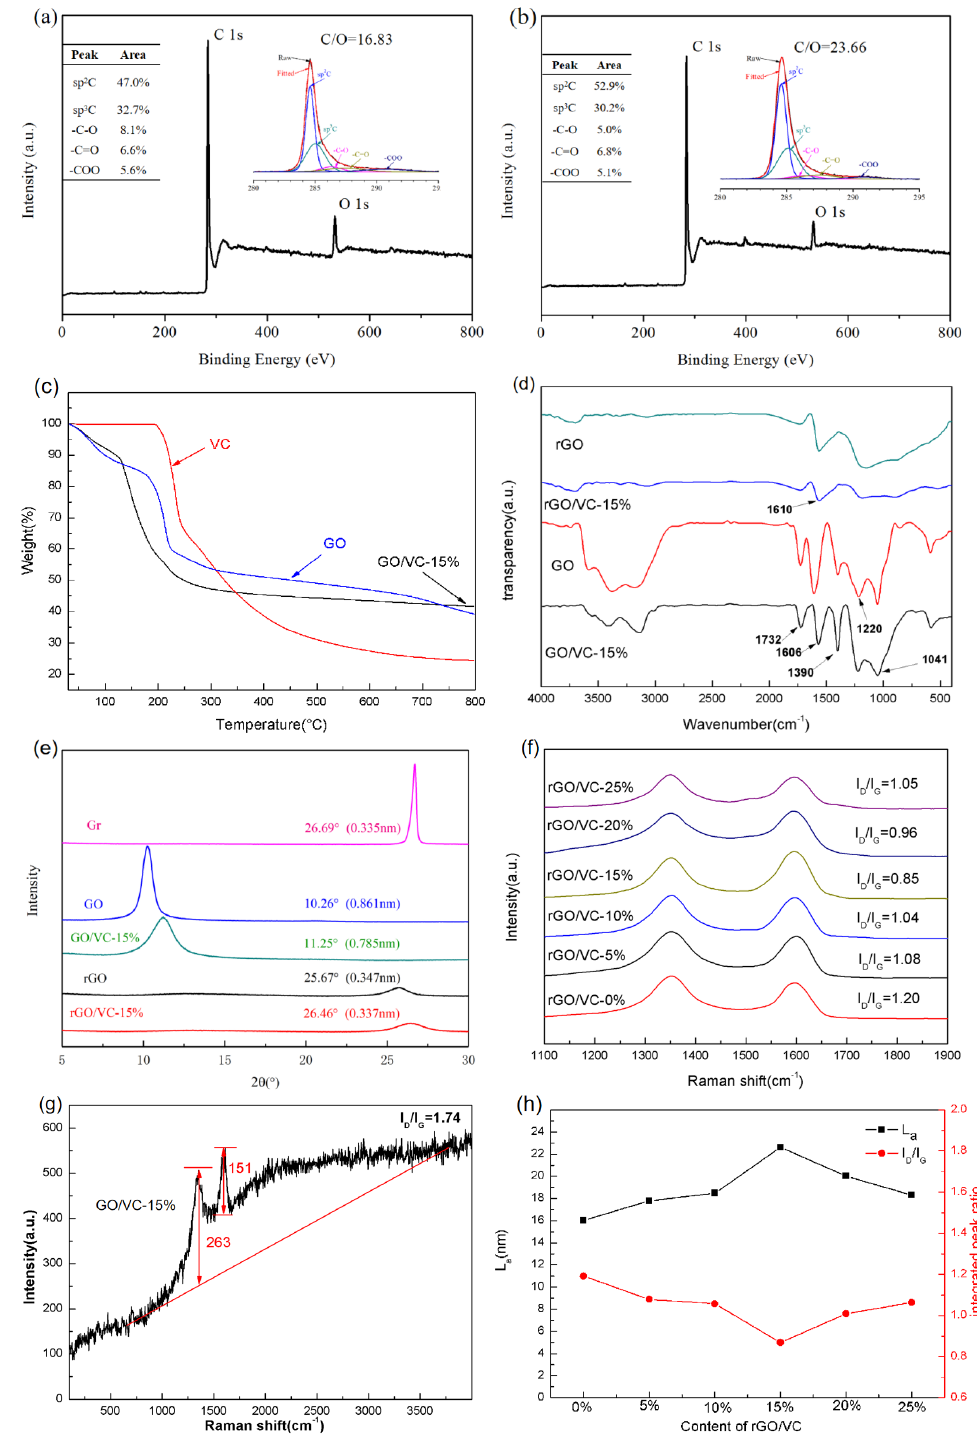
Figure 3. ( a , b ) XPS analysis charts of rGO and rGO/VC-15%; ( c ) the thermal gravimetric analysis of GO, GO/VC-15%, and VC; ( d ) the infrared spectra of GO, GO/VC-15%, rGO and rGO/VC-15%; ( e ) XRD of Gr, GO, GO/VC-15%, rGO and rGO/VC-15%; ( f , g ) Raman spectrum of rGO, rGO/VC-15% and GO/VC-15%; ( h ) I D /I G of rGO, rGO/VC-15% and the size of the crystal field.